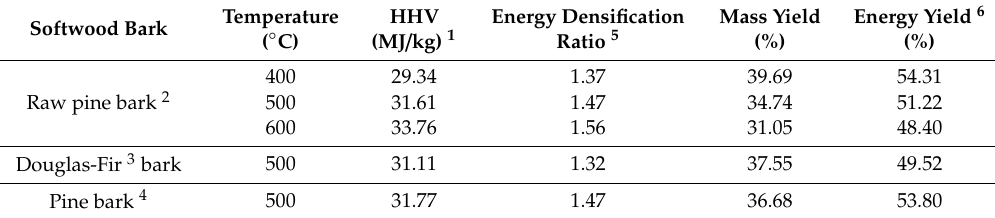
Table 3. HHV, energy densification ratio, mass and energy yield of pyrolysis char produced from raw pine bark, pine and Douglas-Fir